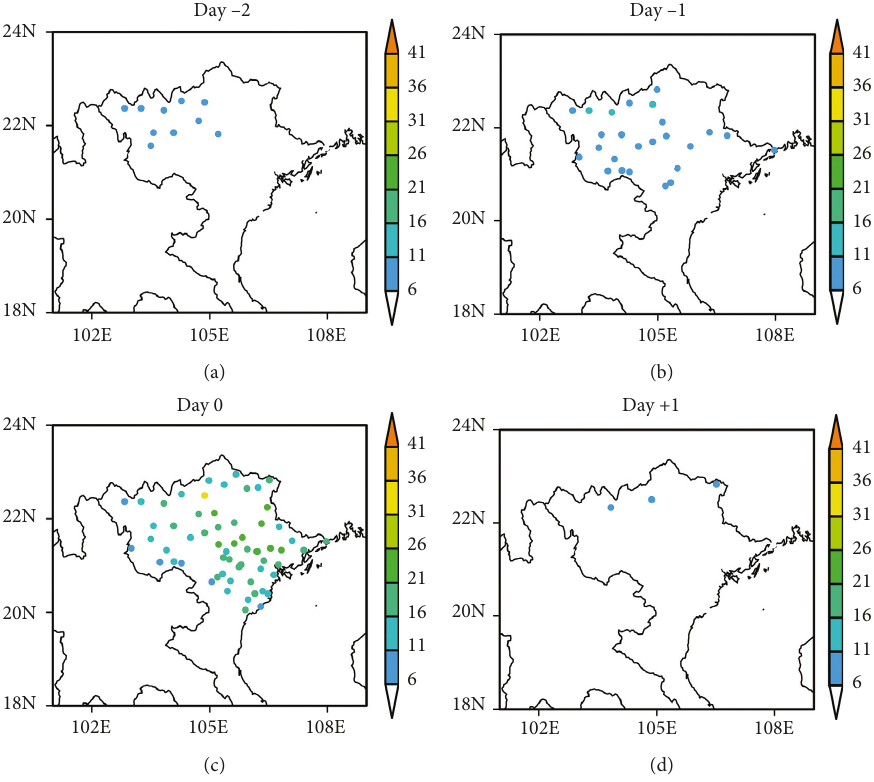
Figure 4: Composite of rainfall at Northern Vietnam stations ( shaded , mm day 1) during the events associated with cold surge and low-level vortex.